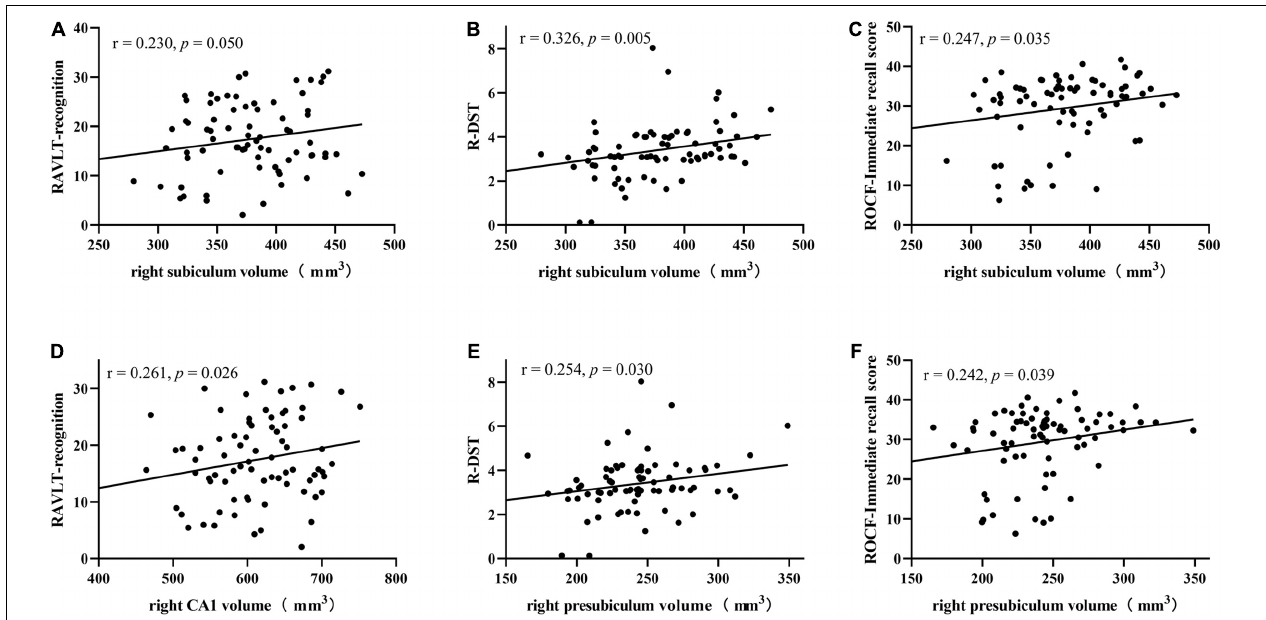
FIGURE 4 | Correlations between right subiculum volumes and RAVLT recognition (A) , R-DST (B) , and ROCF immediate recall scores (C) , right CA1 volumes and RAVLT recognition scores (D) , right presubiculum volumes and R-DST (E) , ROCF immediate recall scores (F) in SIVD patients. RAVLT, Rey’s Auditory Verbal Learning Test; R-DST, reverse digit span test. Volume data are expressed in mm 3